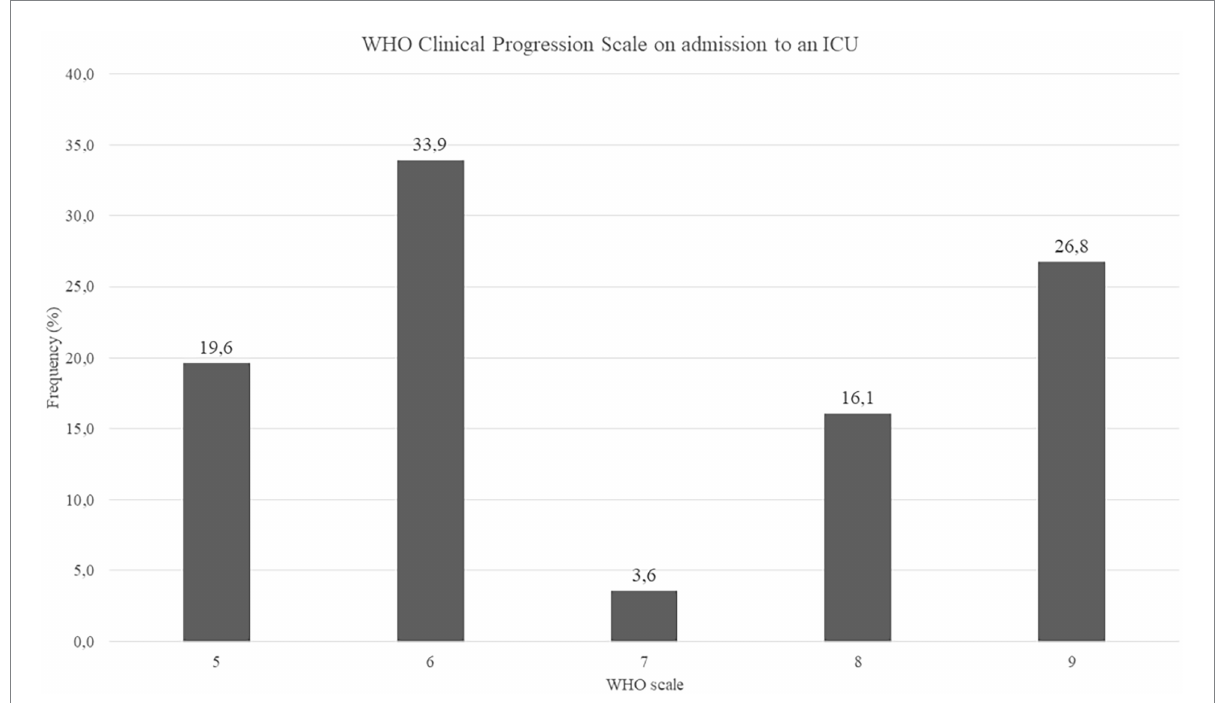
FIGURE 1 WHO Clinical Progression Scale on admission to an ICU, N = 56, data presented as